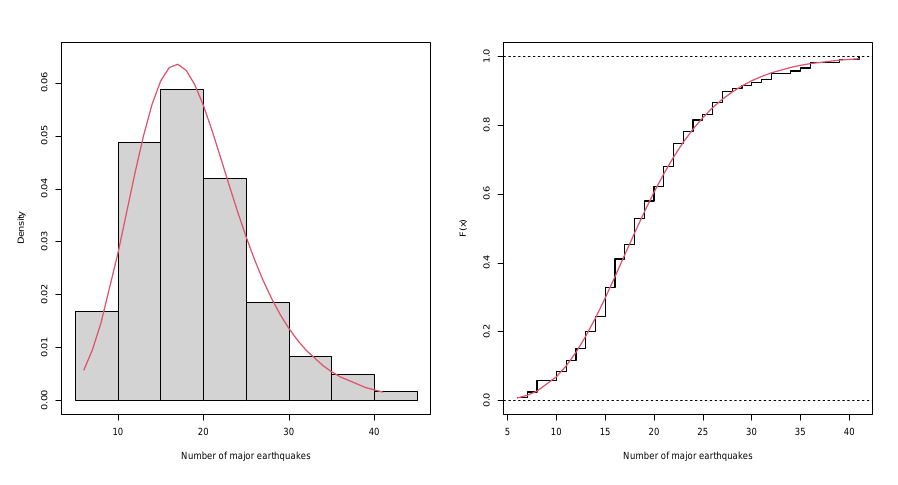
Figure 9 – The McWP distribution for earthquake data.